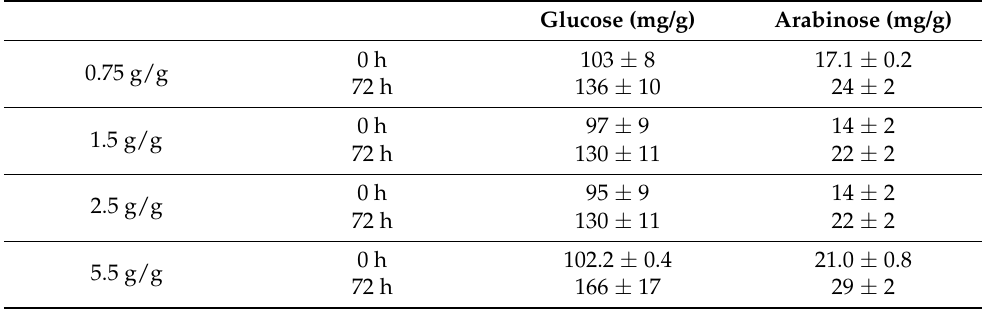
Table 2. Sugars released by enzymatic treatment of untreated COP with different crude extract loads.